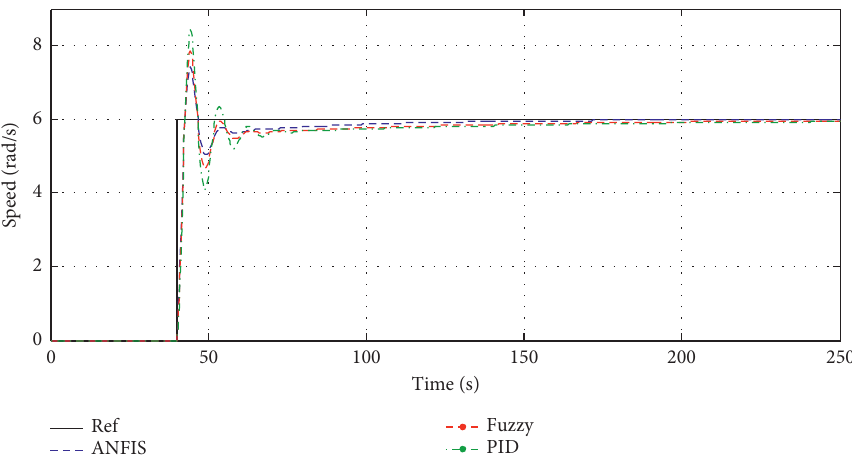
Figure 14: Reference speed and PMSM speed using ANFIS, Fuzzy, and PID.